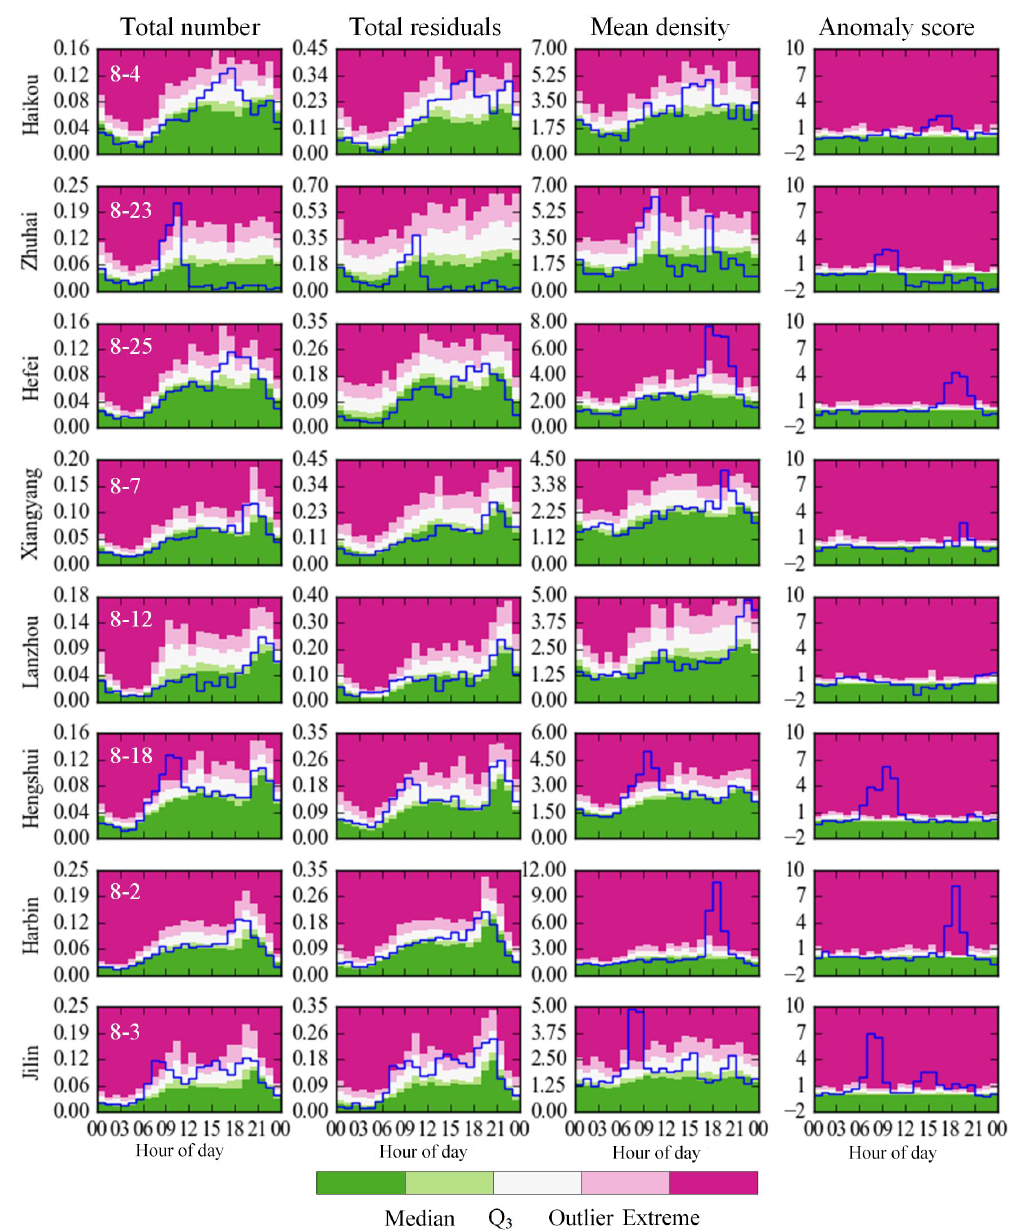
Figure 6. Intra-day variations of the NLR, total residuals, mean density, and anomaly score within 24h of a typical flooding event in each of the